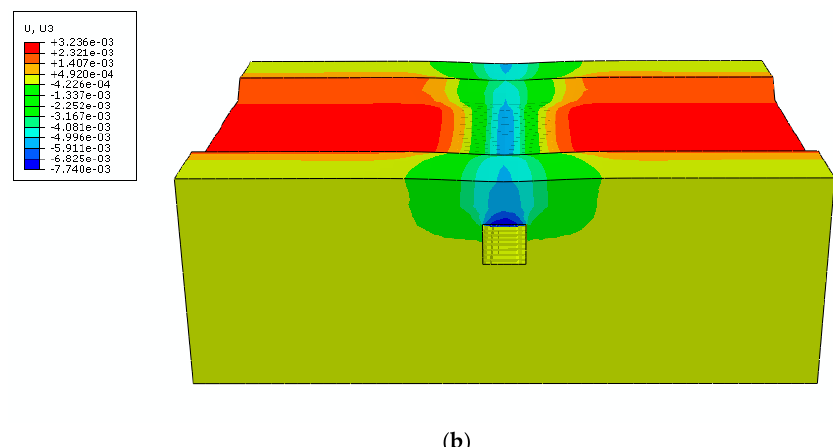
Figure 8. Vertical deformation cloud. ( a ) Left line tunnel; ( b ) Right line tunnel.